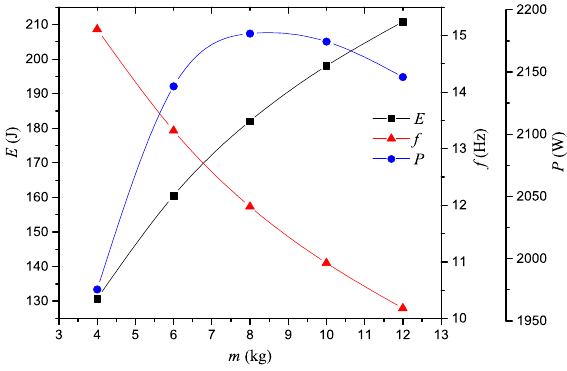
Figure 9. Variations of E , f and P versus mass of the impact body m .